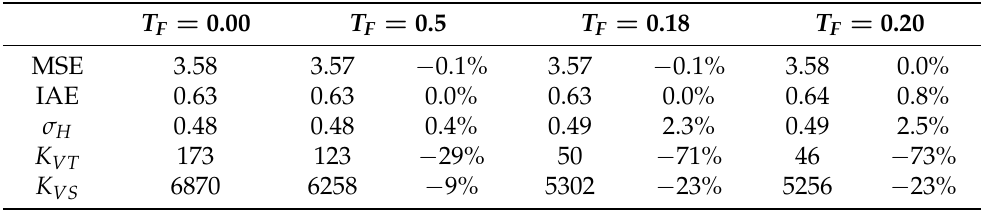
Table 9. Filtering impact on G 4 ( s )